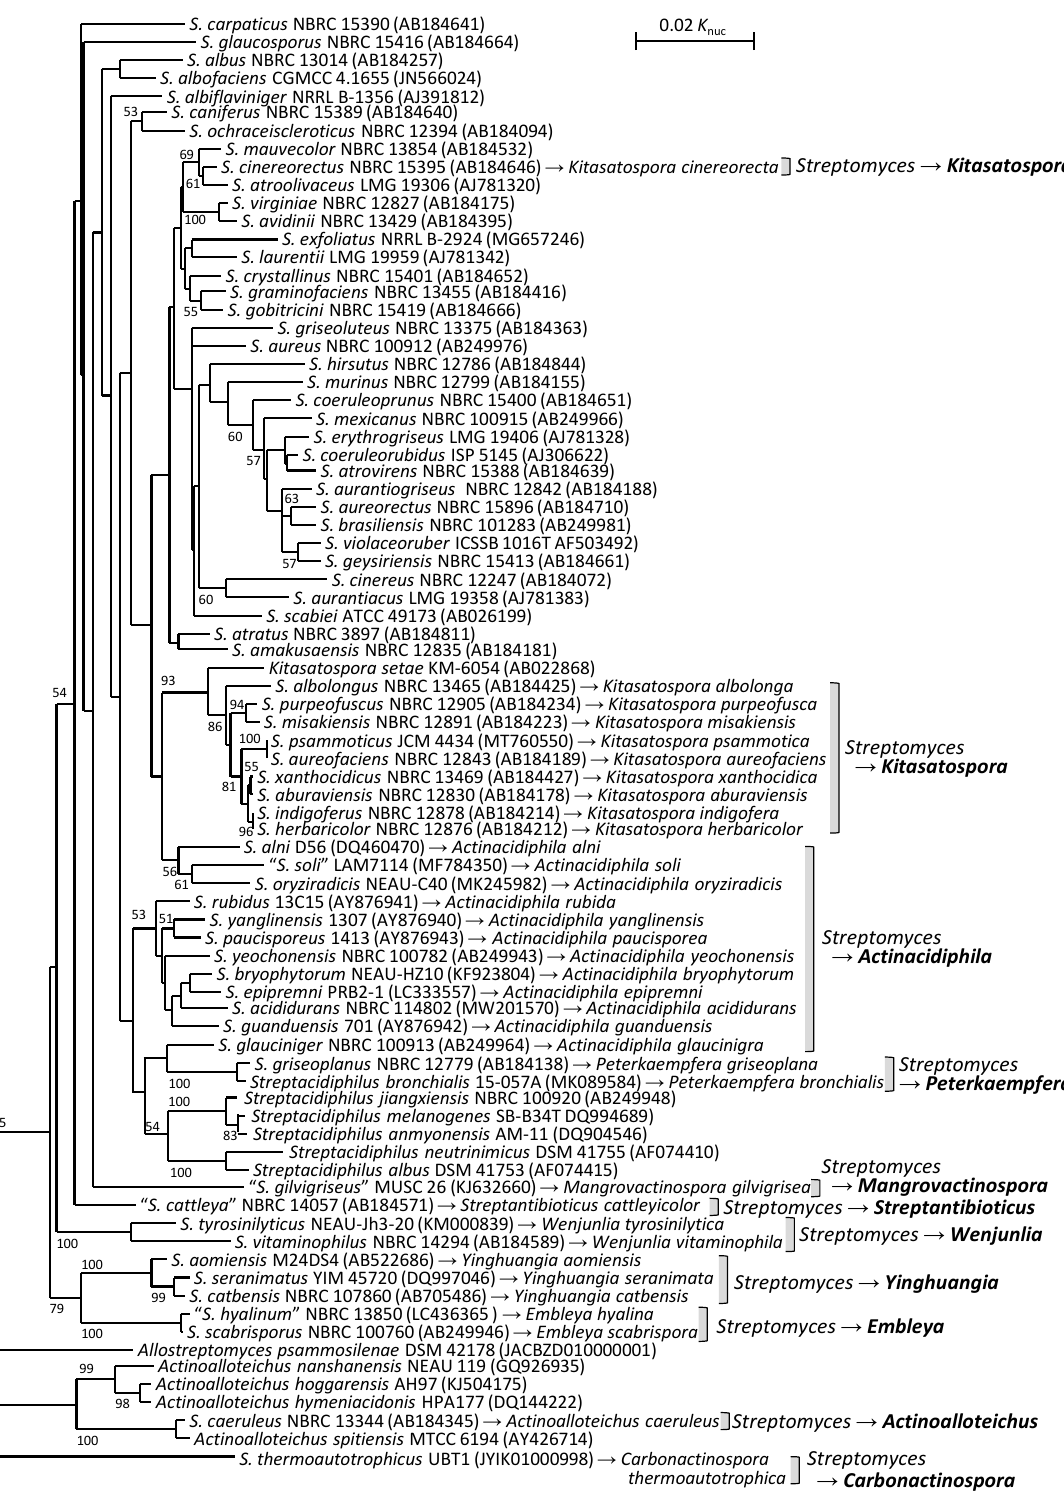
Figure 2. Phylogenetic tree of type strains of Streptomyces species transferred to other genera based on 16S rRNA gene sequences. In addition to the members in Table 1, type strains of 35 Streptomyces species, Kitasatospora setae , four Streptachidiphilus species, Allostreptomyces psammosilienae and four Actinoalloteichus species are included as references. Numbers on branches indicate the percentage bootstrap values of 1000 replicates; only values >50% are indicated.